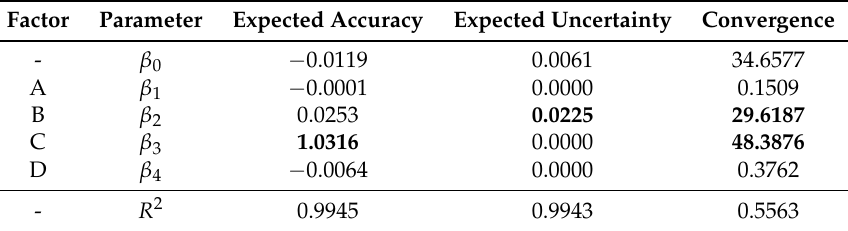
Table 3. Multiple linear regression coefficients obtained for the three measures of performance of the range filter and quality of their estimations ( R 2 ). Maximum values are highlighted in